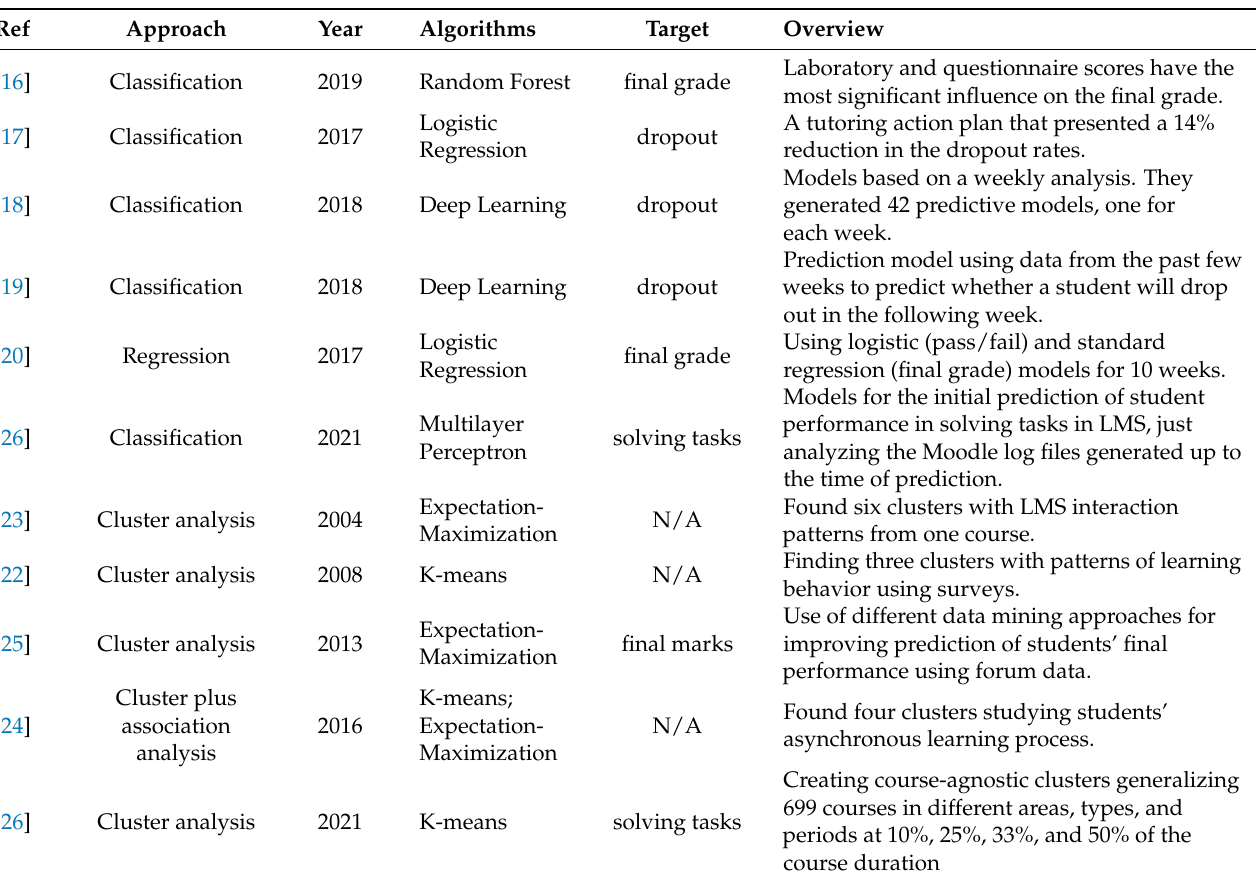
Table 1. Summary of the literature review of distance learning students’ performance